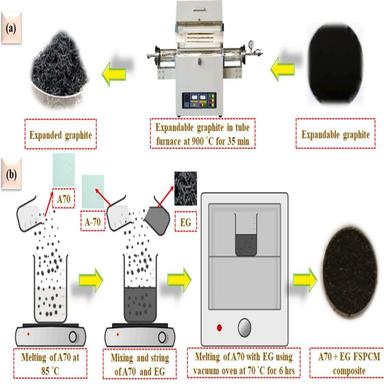
Schematic representation for preparing (a) expanded graphite nanoparticle (b) SS-PCM composite.